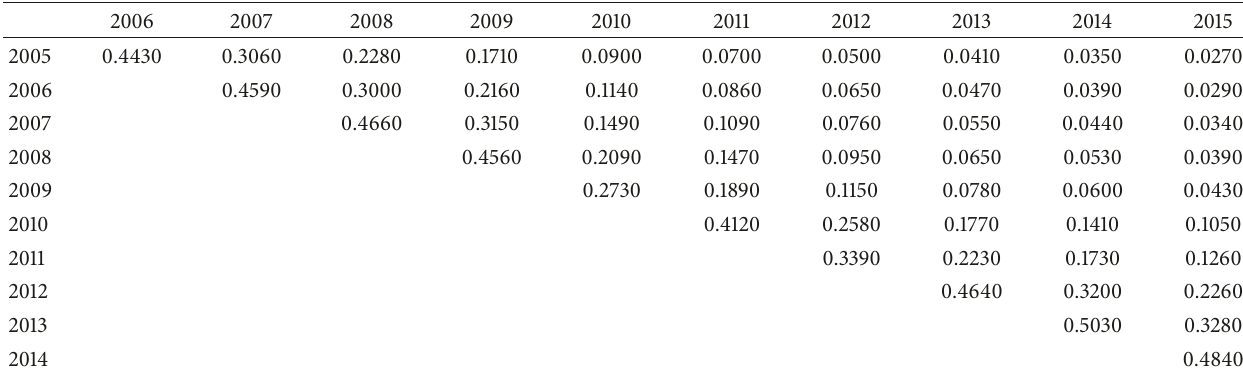
Table 2: Jaccard similarity of the JLG network over time.